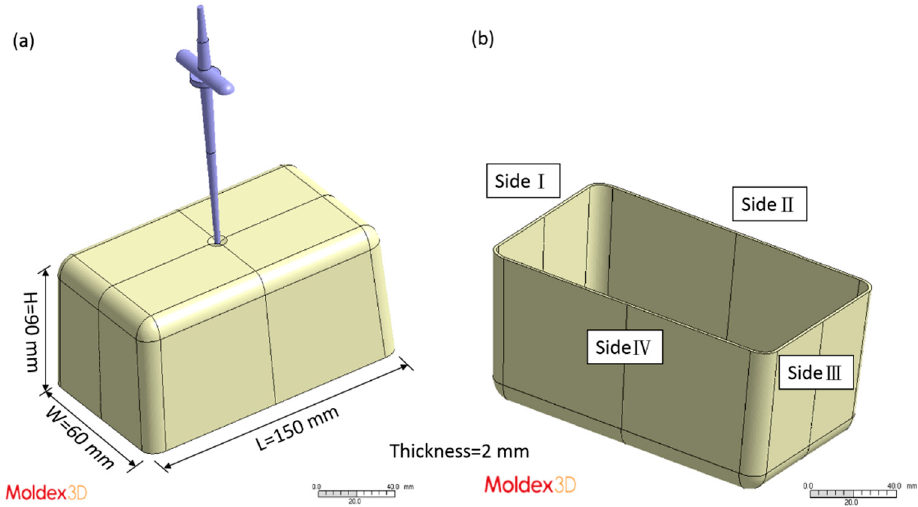
Figure 2. ( a ) Model including sample and runner; ( b ) naming of the sample sides.